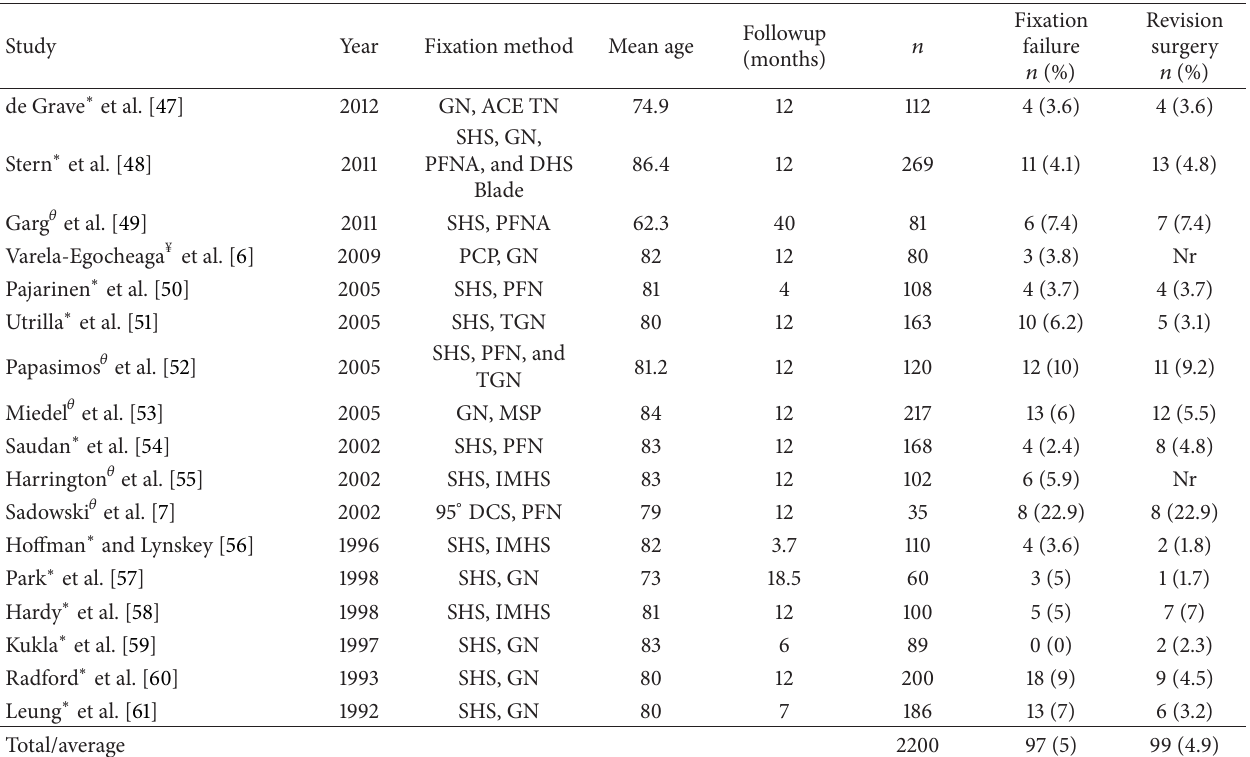
Table 3: Incidence of fixation failure and reoperation in peritrochanteric fractures of the femur. All patients > 60years. Study Year Fixation method Mean age